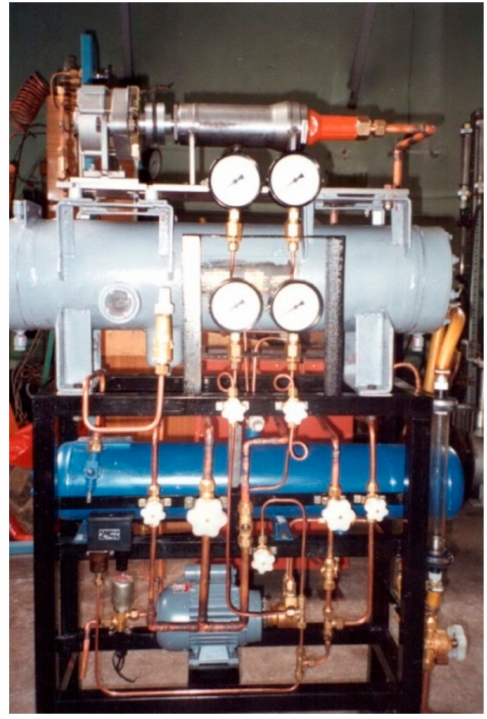
Figure 5. A detailed view of a micro-power ORC test stand implemented in the mid-1990s at the Wrocław University of